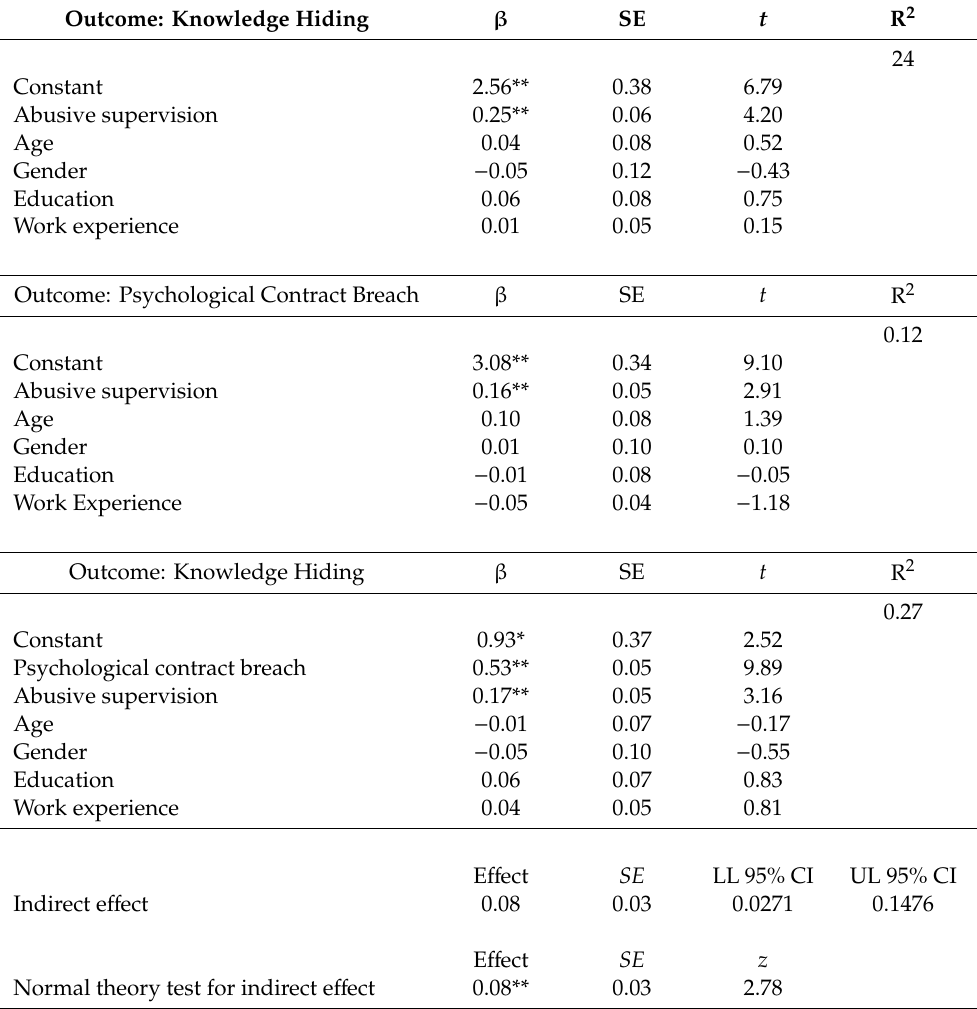
Table 4. Mediation e ff ect.